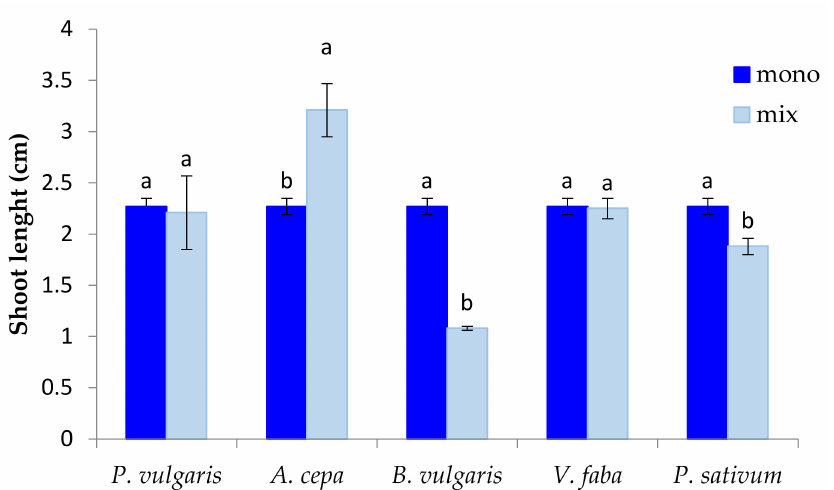
Figure 8. Shoot length of P. oleracea grown with crop seeds (mono = weed alone; mix = weed grown together with crop). Bars represent the means of 4 replicates ± SE. Bars topped by the same letter indicate no significant difference between treatments at the 5% level using Duncan’s multiple-range test.